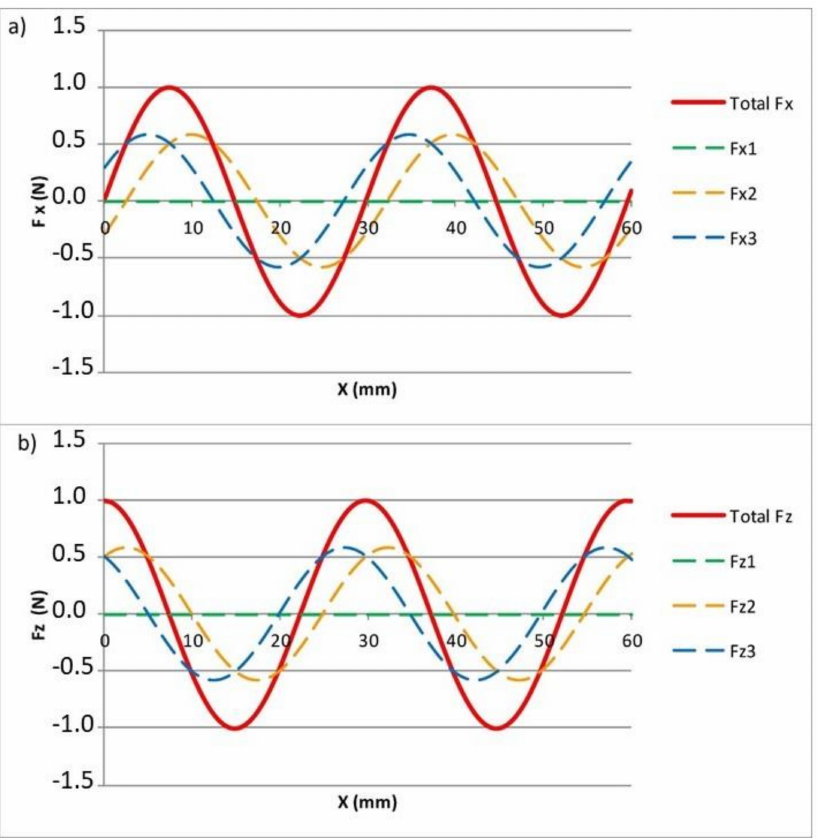
Figure 2. F x ( a ) and F z ( b ) along axis-of-movement for I a = 0 A, I b = − 0.3593 A, and I c = 0.3593